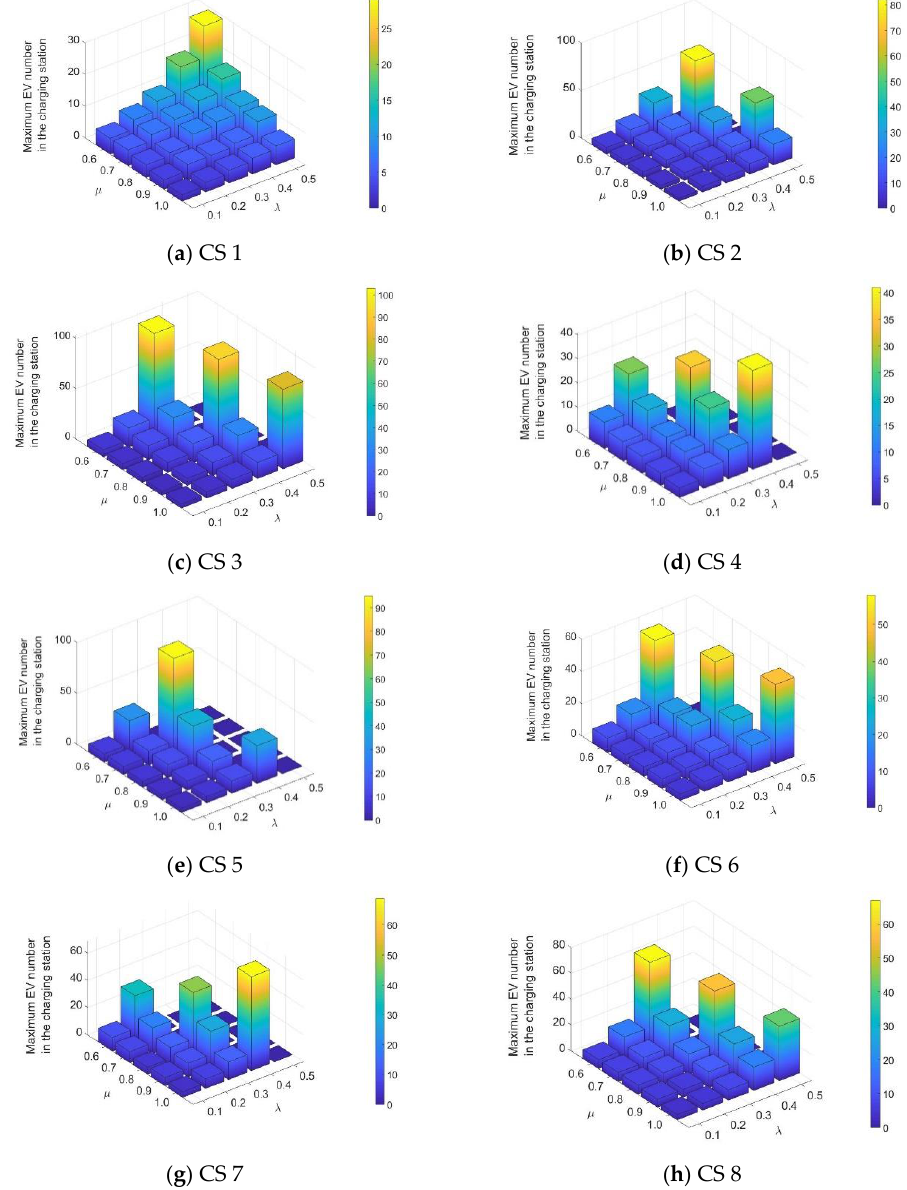
Figure 8. Change trends of the maximum EV number at each charging station under the SDD strategy, where λ is the possibility of charging demand occurrence in normal nodes at each time slot, and µ is the possibility of an EV leaving the charging station after completing charging at each time